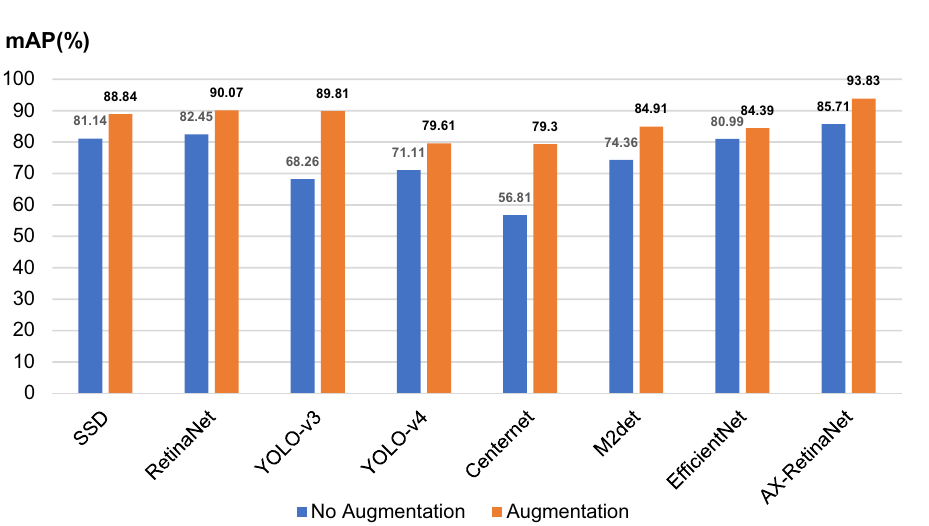
Figure 10. mAP values of the detection and identification results of different